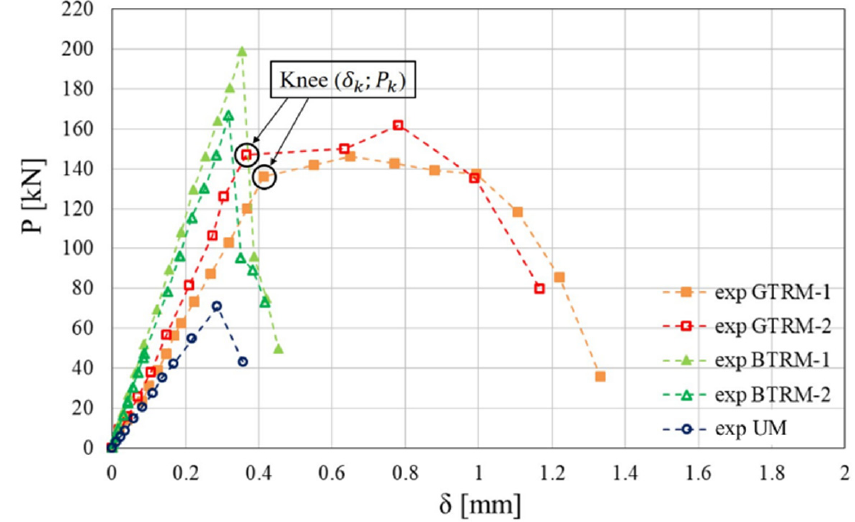
Figure 5. Experimental results: vertical load (P) vs vertical displacement ( δ ).